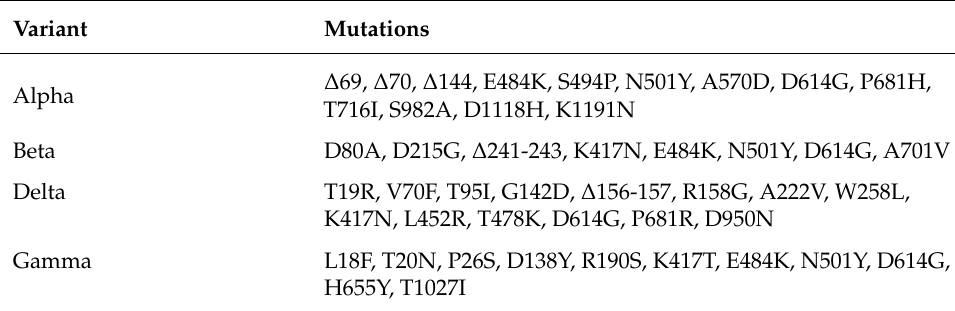
Table 2. Variants and their characteristic